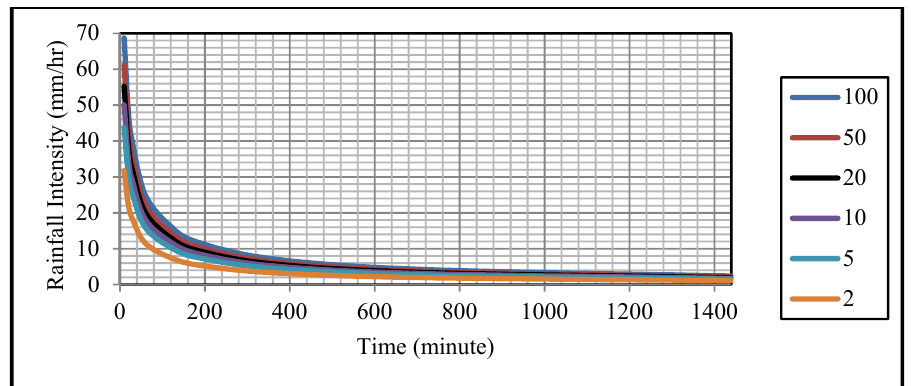
Figure 6. Curve values (intensity, duration, and frequency) for the study station.